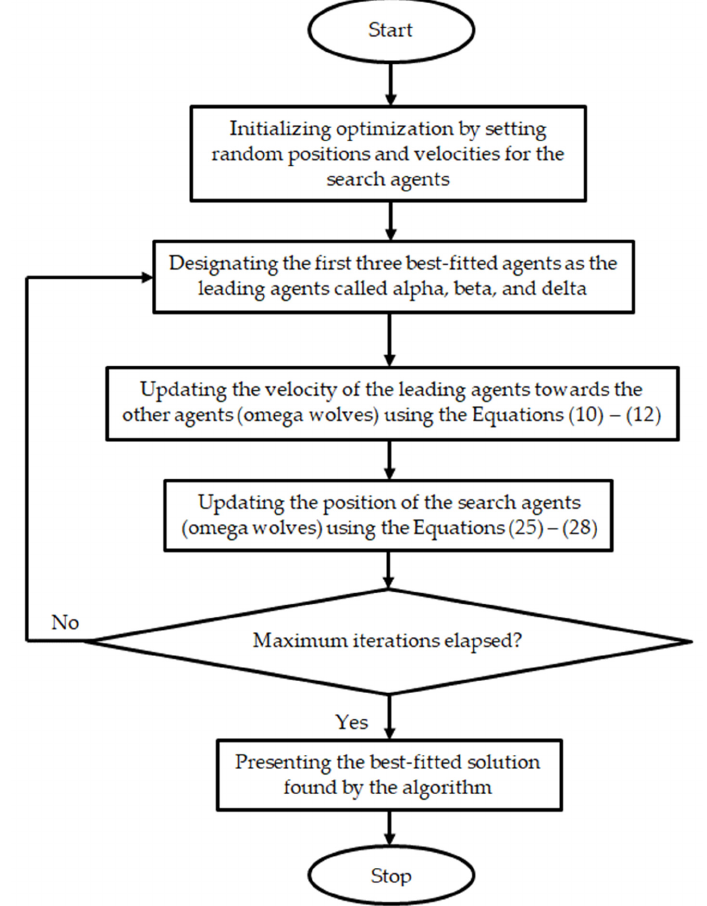
Figure 2. Flowchart of